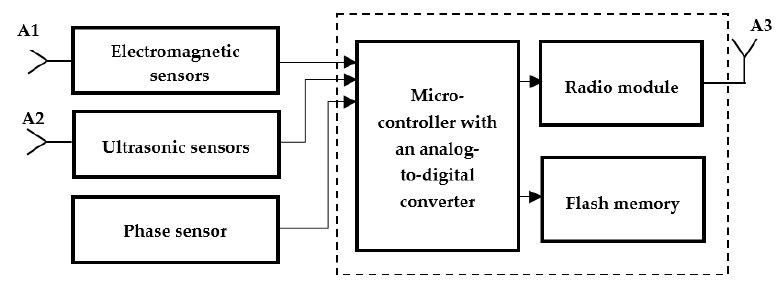
Figure 1. Flowchart of a non-contact diagnostic device.